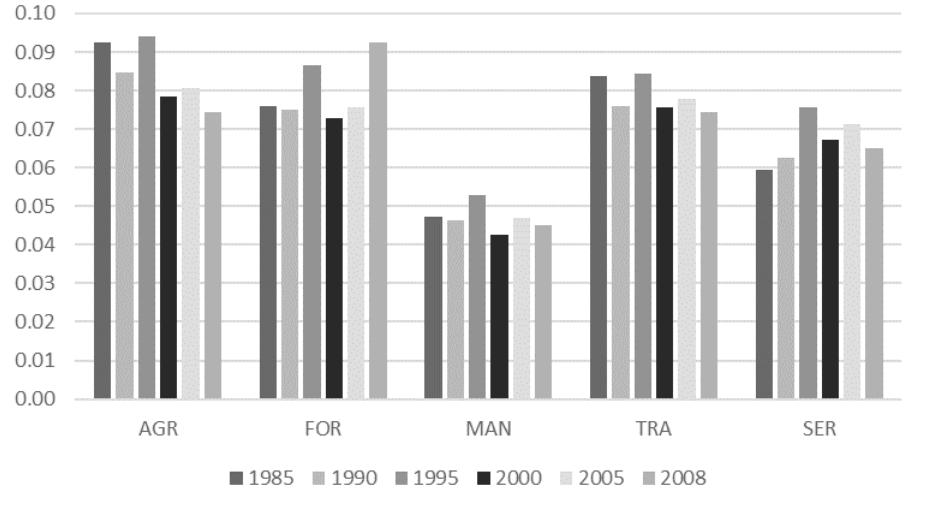
Figure 1: Total Multiplier Effect 1985-2008